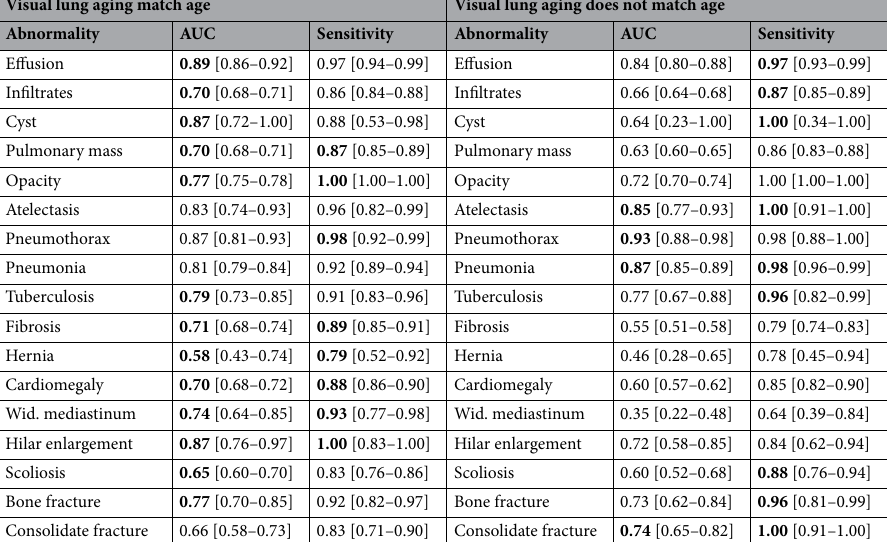
Table 4. The age information is integrated into the proposed framework. A separate logistic regression model was implemented to predict visual lung aging from the age feature. The model performance was of 0.79 and 0.70 AUC and accuracy. This table presents the framework results in terms of the area under the receiving operator curve and sensitivity against the patients whose visual lung aging was correctly/incorrectly predicted from their age. The higher number for each abnormality is highlighted in